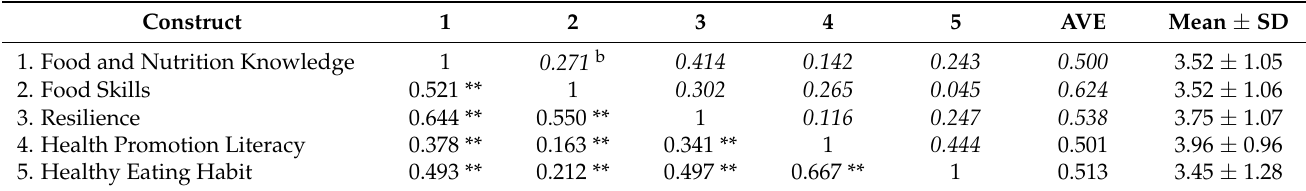
Table 2. Means, standard deviations, and correlation analyses.